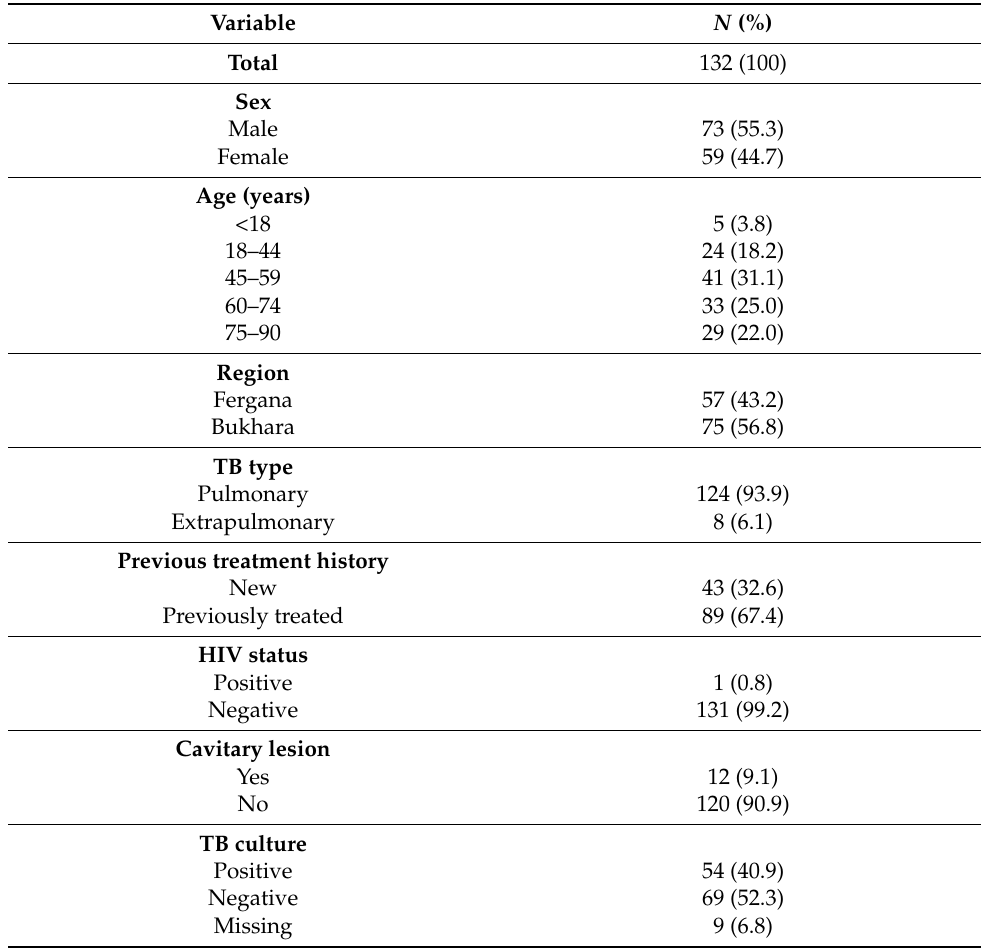
Table 1. Demographic and clinical characteristics of TB patients “resistant to isoniazid and